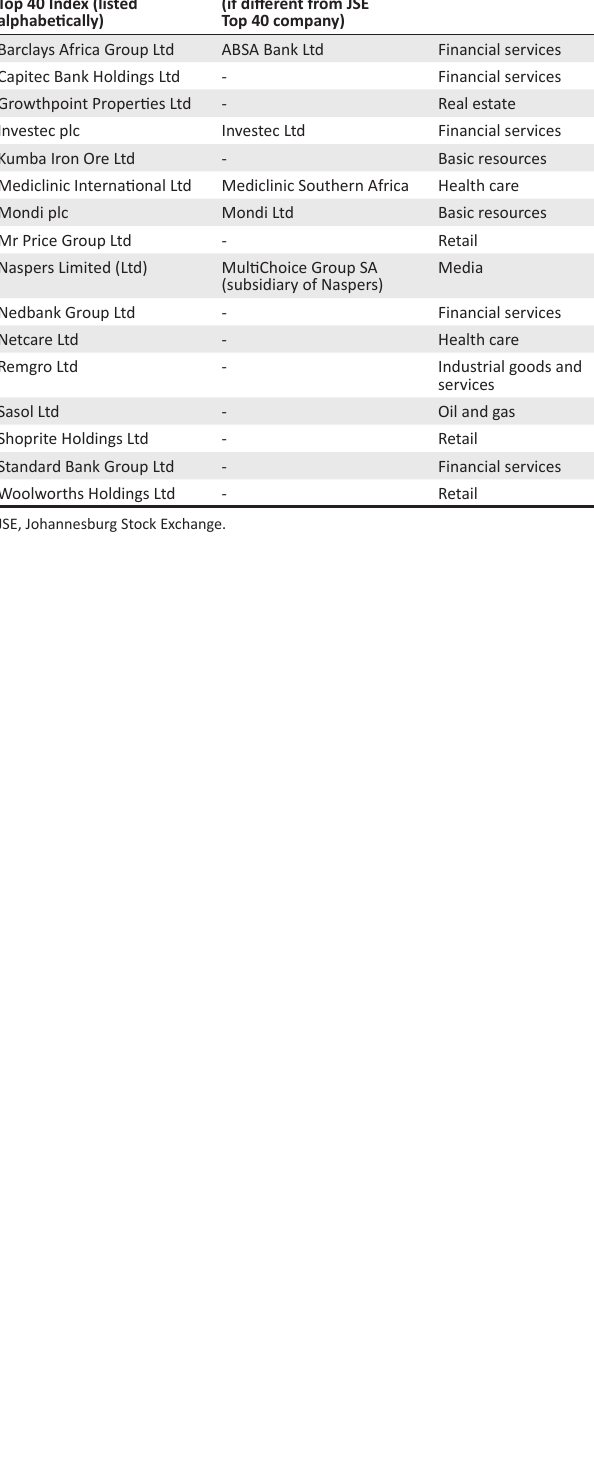
TABLE 1-A1: The following table sets out the sectors in which the respondents of the questionnaire operate. Company listed on JSE Top 40 Index (listed